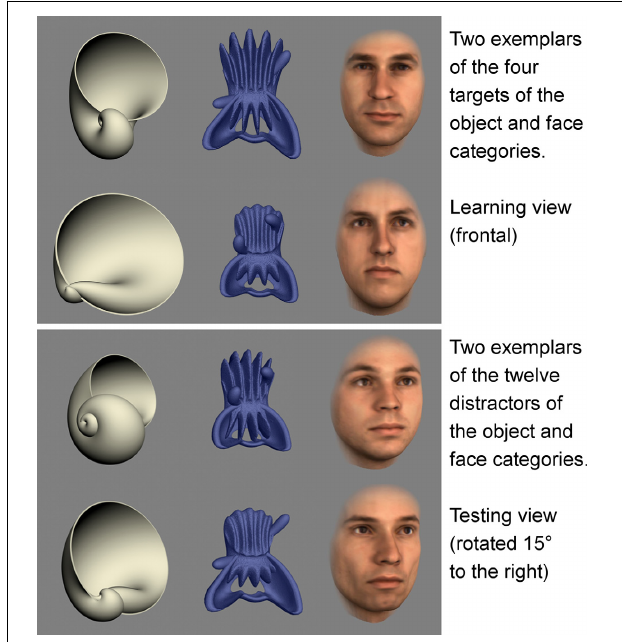
FIGURE 8 | Exemplars of the stimuli used in the object recognition experiment.